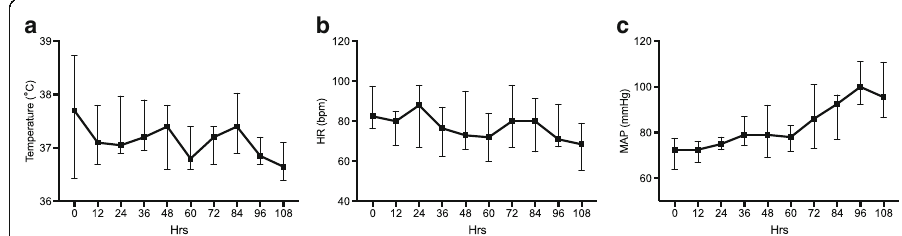
Fig. 2 Physiological markers of stress. Median and interquartile range for each time point. a Temperature.